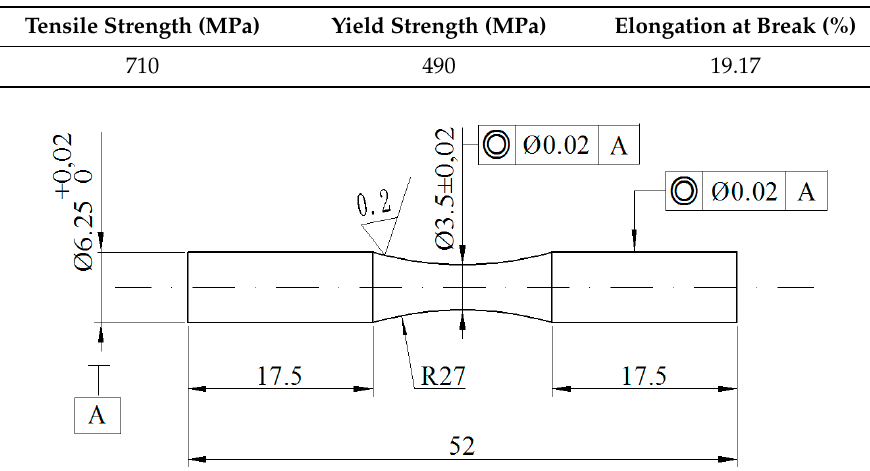
Figure 1. Fatigue specimen geometry (dimensions in mm).